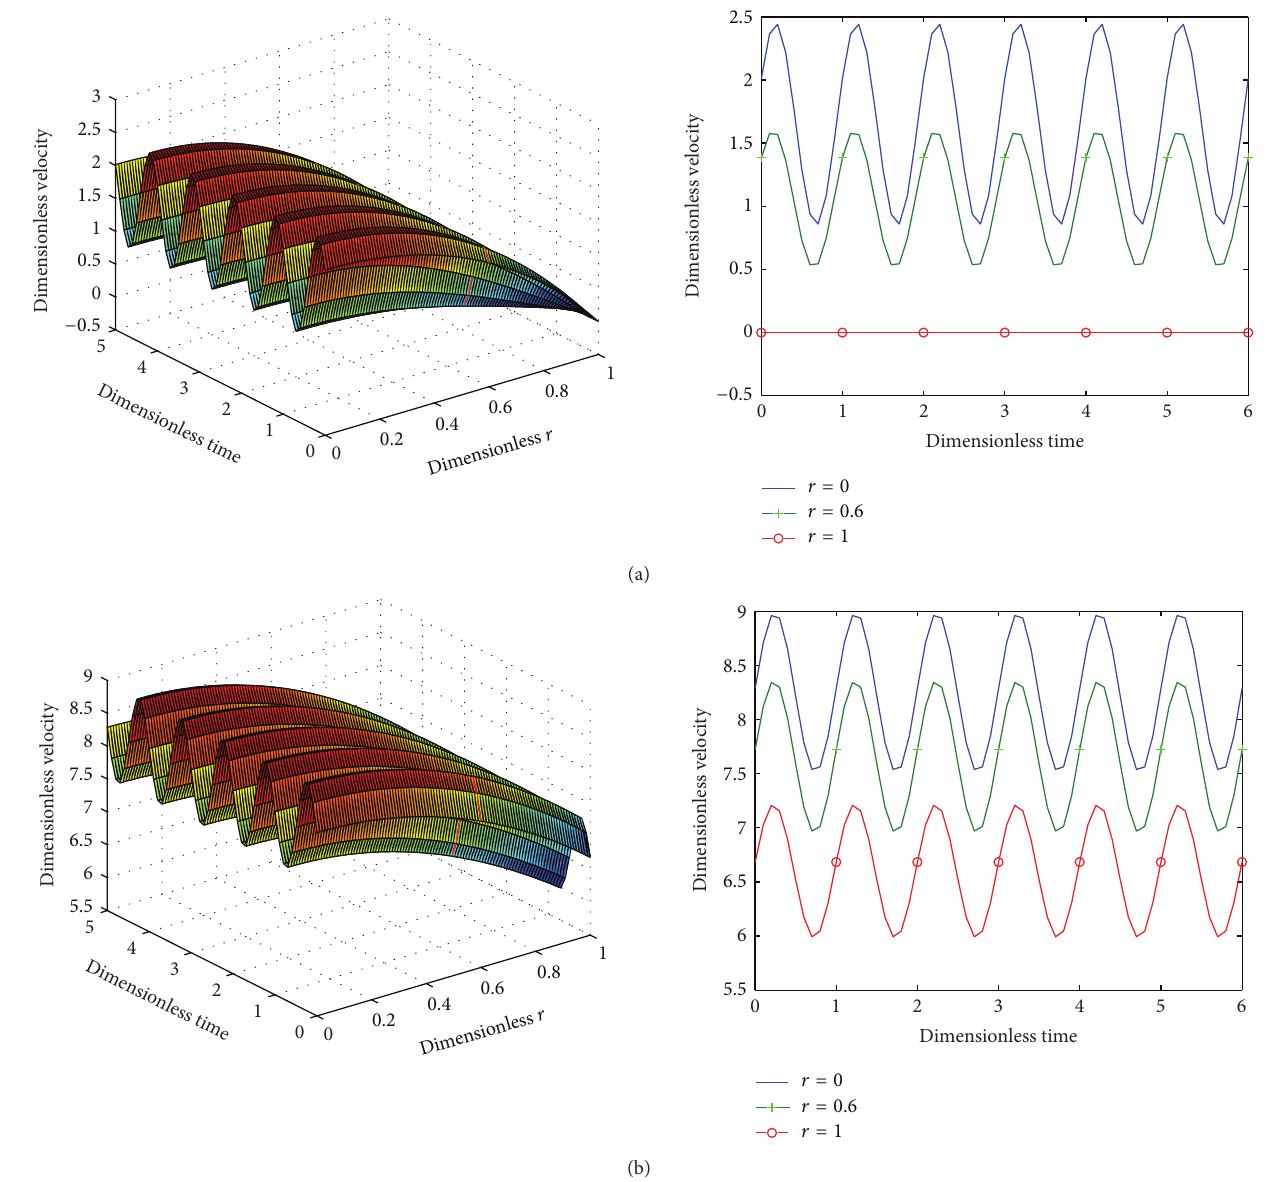
Figure 2: The velocity profile in the large artery with radius 0.50 cm under two different slip parameter values: (a) 𝑙 𝑏 = 0 ; (b) 𝑙 𝑏 = 2 . In the figure, the 3D graphs show the variation of velocity as a function of time and location, while the 2D graphs show the variation of velocity with time at three radial locations including the artery centre ( 𝑟 = 0 ), the interface of inner-outer layer ( 𝑟 = 0.6 ), and the arterial wall ( 𝑟 = 1